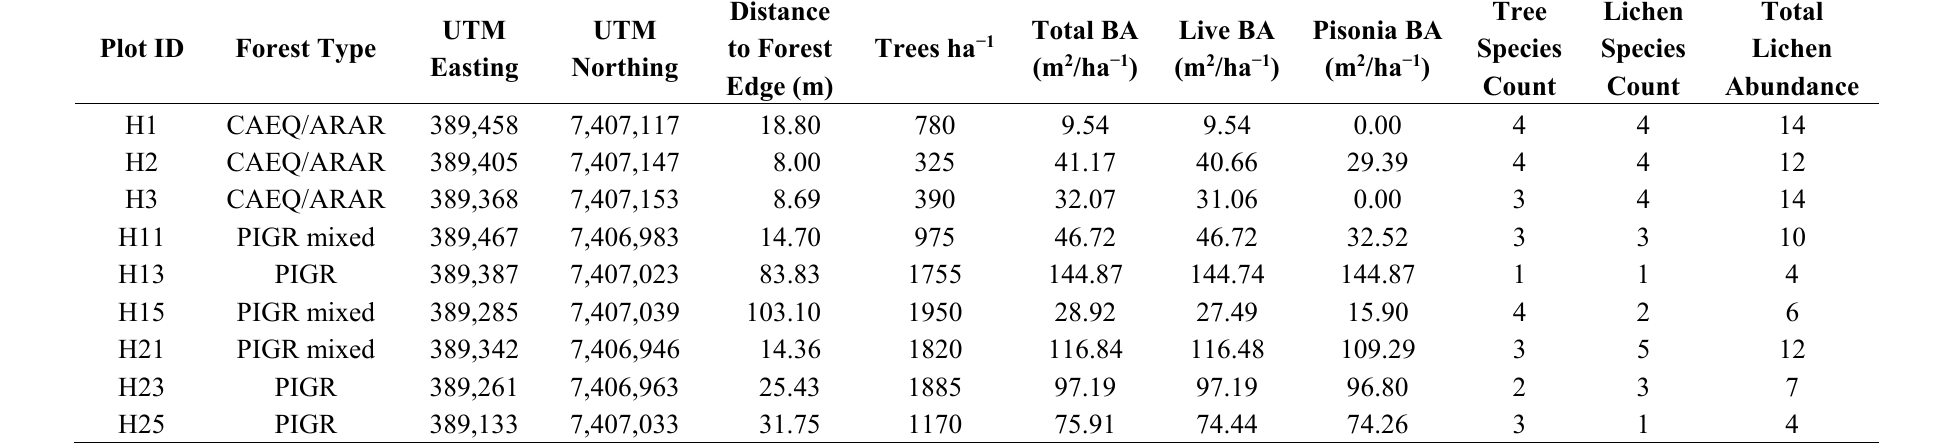
Table 1. Forest statistics by sample location (plot) for Heron Island, Australia. Forest Types are comprised of the principal overstorey tree species: CAEQ/ARAR = Casuarina equisetifolia / Argusia argentea ; PIGR mixed = 50%–95% Pisonia grandis with lesser coverage of CAEQ, ARAR, Pandanus heronensis (PAHE), and Pipturus argenteus (PIAR); PIGR ≥ 95% PIGR. BA = basal